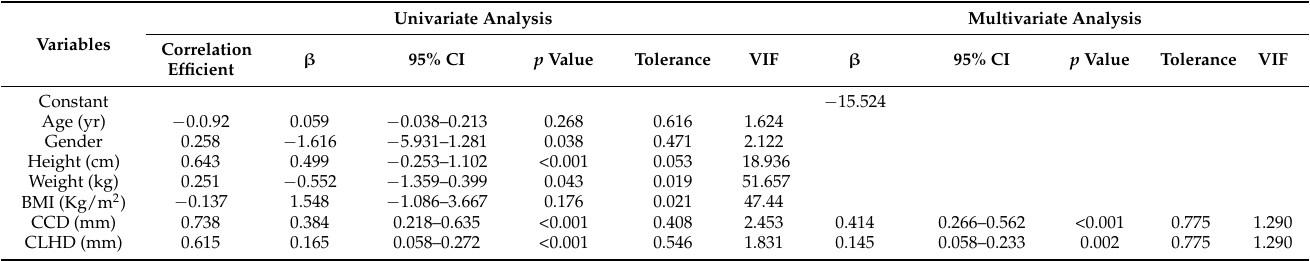
Table 3. Results of linear regression analysis for actual GDT insertion depth and patient